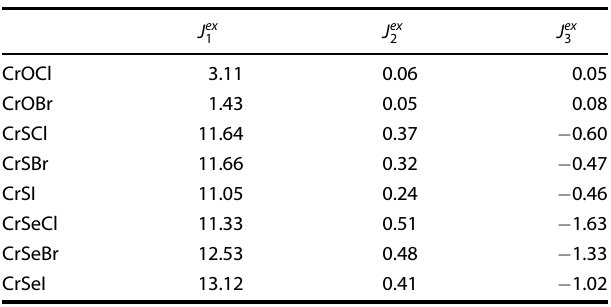
Fig. 2 Magnetic and electronic properties of CrSeI monolayer. a Energy dependence on the magnetic propagation vector q , ( b ) density of state (DOS) of the CrSeI monolayer. The valence band maximum (VBM) energy is set to zero. Table 2. Magnetic properties of CrXY